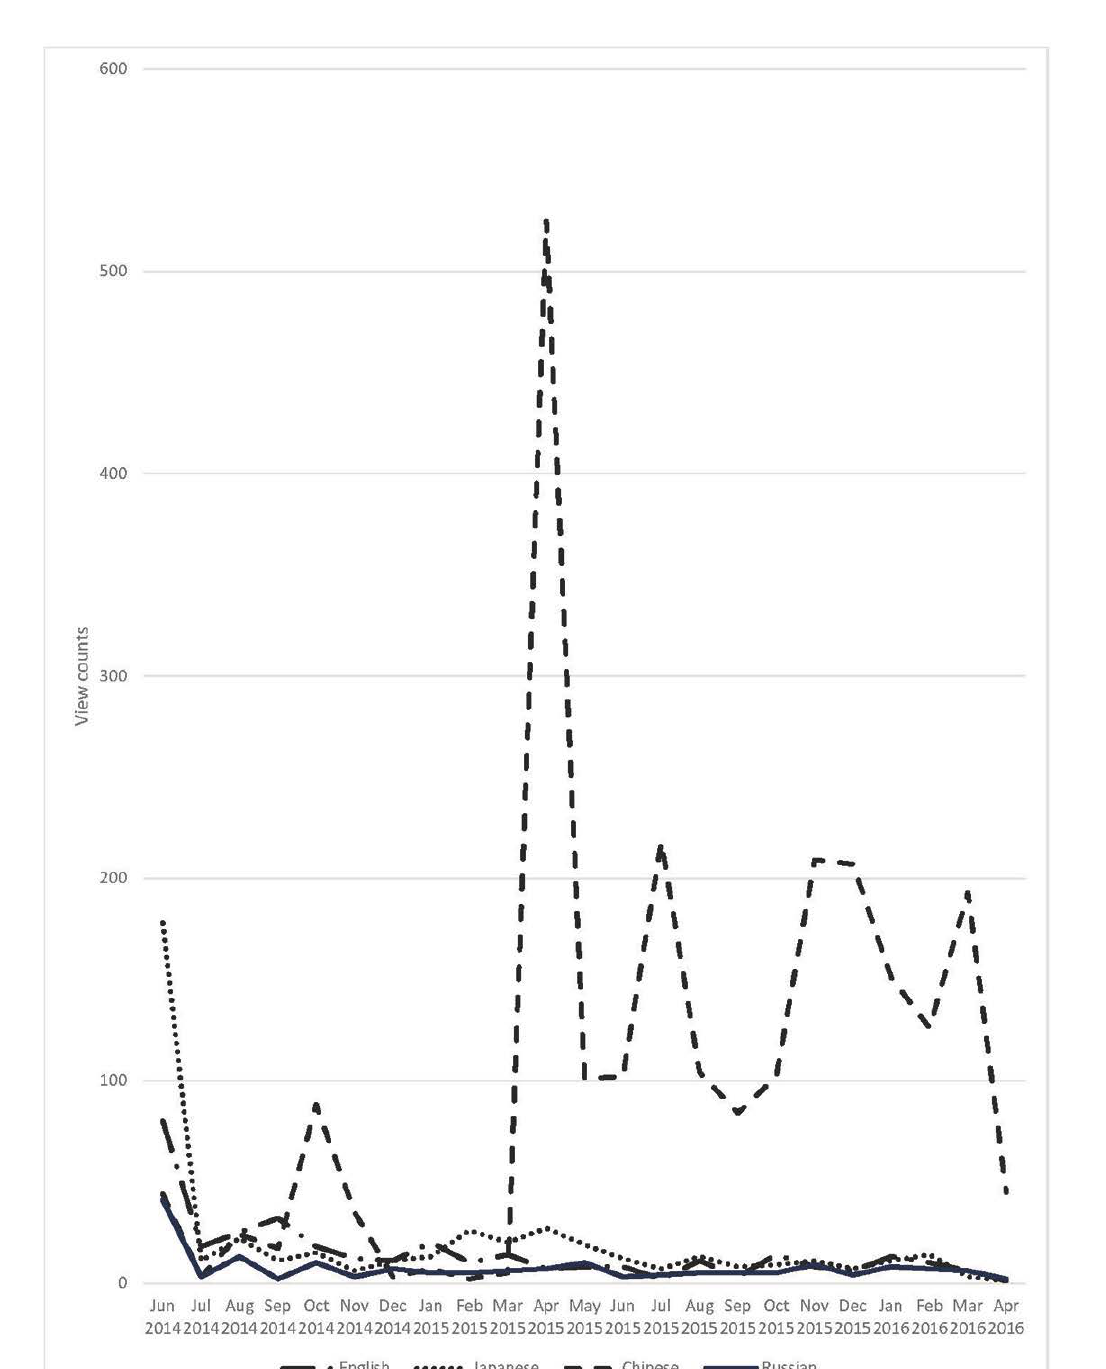
Figure 1 View counts over time for each language